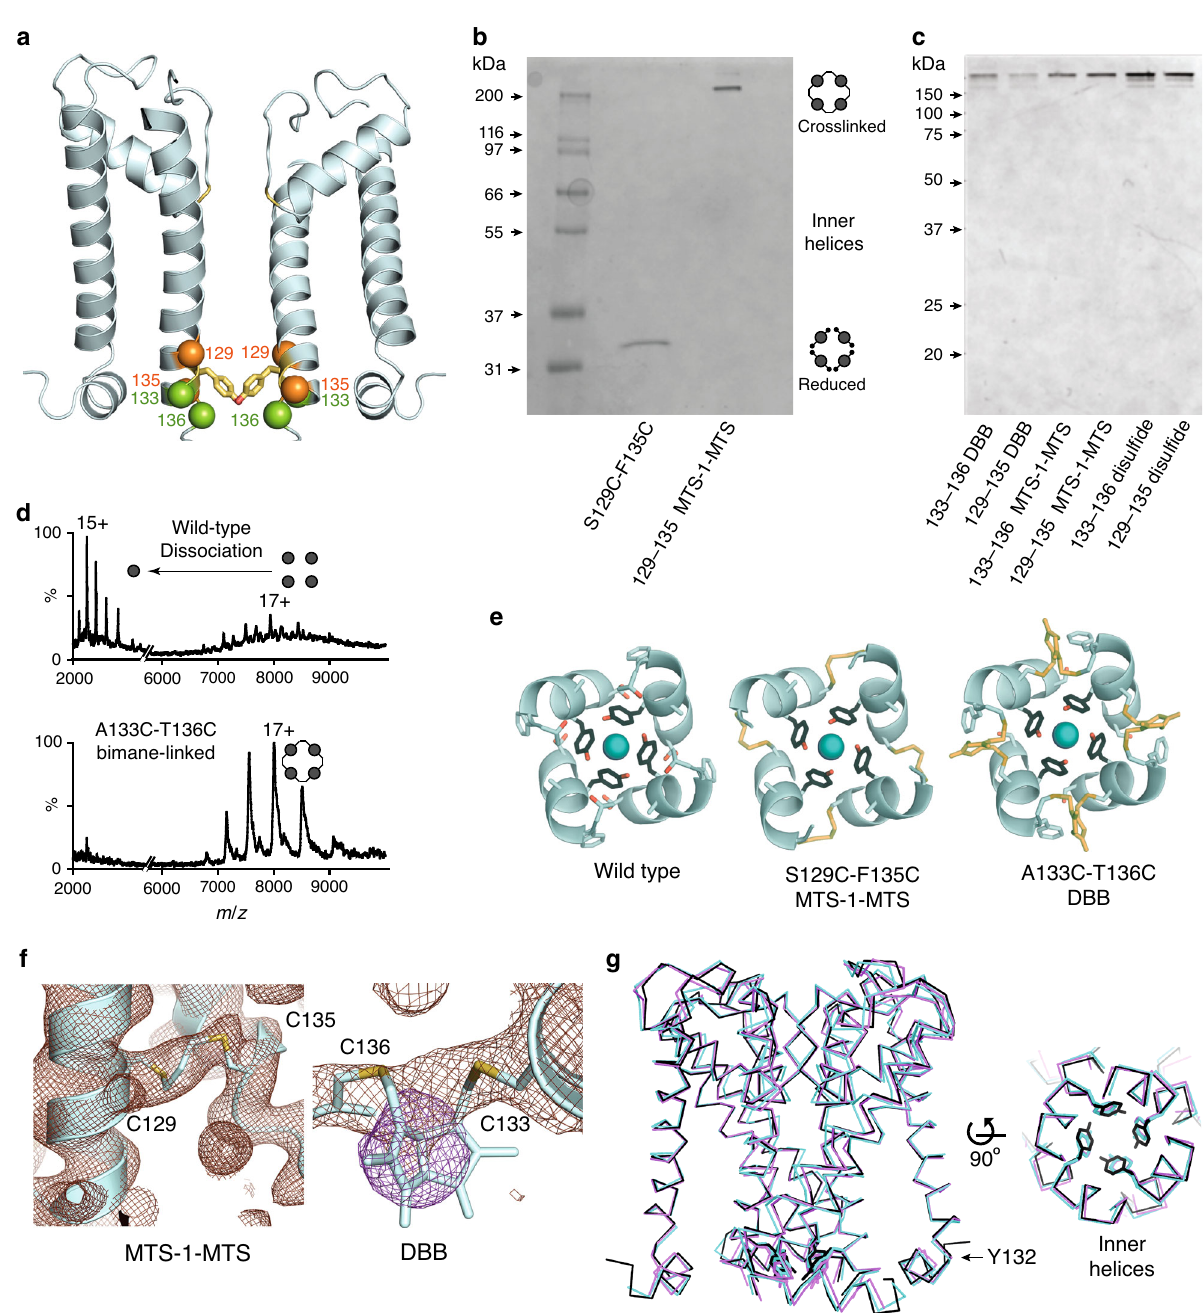
Fig. 3 Crosslinking around Tyr132 forms covalent tetramers and limits inner helix movement. a Sites of the paired cysteine mutations relative to Tyr132, with C α shown as spheres. Sites of 129 and 135 are colored orange, and 133 and 136 shown in green. For clarity, only two subunits are depicted. b In the presence of crosslinker, the cysteine-pair mutant S129C-F135C MTS-1-MTS migrates on SDS-PAGE as a tetramer, whereas reduced S129C-F135C migrates as a monomer. Both samples are of reconstituted proteoliposomes and are representative of at least n = 20 gels. c All six mutant-crosslinker combinations migrate as tetramers and are representative of at least n = 10 gels. d Native mass spectrometry using collision-induced dissociation in the gas phase results in loss of signal for wild type and reduced cysteine-pair mutants, but not for covalently crosslinked mutants. Spectra for wild-type (upper) and dibromobimane-linked A133C-T136C (lower). e Comparative cross-sectional slices through crystal structures at the Tyr132 collar. Only the inner helices are shown. Crosslinkers are depicted as yellow sticks and K + ions as deep cyan spheres. f Electron density for the crosslinkers is present at all subunit interfaces of S129C-F135C (MTS-1-MTS) and A133C-T136C (dibromobimane). Left panel shows a 3.1 Å composite omit map (2| F o | − | F c |) contoured at 1.5 σ and showing strong density for the bridging S-CH F − | F σ (brown mesh), 2 -S moiety. Right panel shows a simple 4.1 Å 2| o | c | omit map contoured at 1 overlaid with an unsharpened | F o | − | F c | omit map contoured at 3 σ (purple mesh) revealing the bimane moiety. g Superposition of C α traces of crosslinked structures S129C-F135C MTS-1-MTS (cyan) and A133C-T136C DBB (purple) onto the native pore structure (black). Two subunits have been omitted for clarity in the left-hand